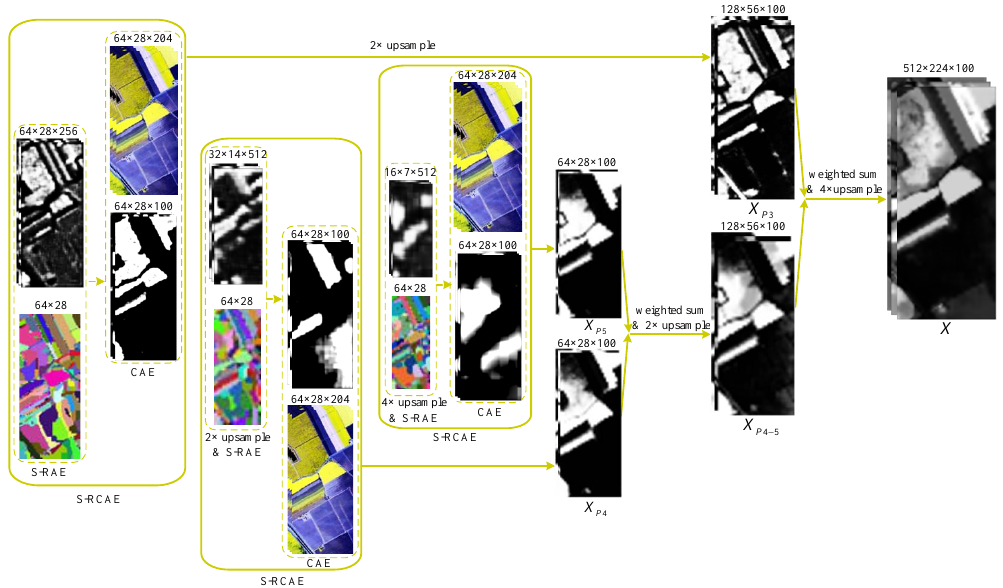
Figure 3. Illustration of the proposed MS-RCAE (All the sizes are subject to the digital markers). A case of the Salinas